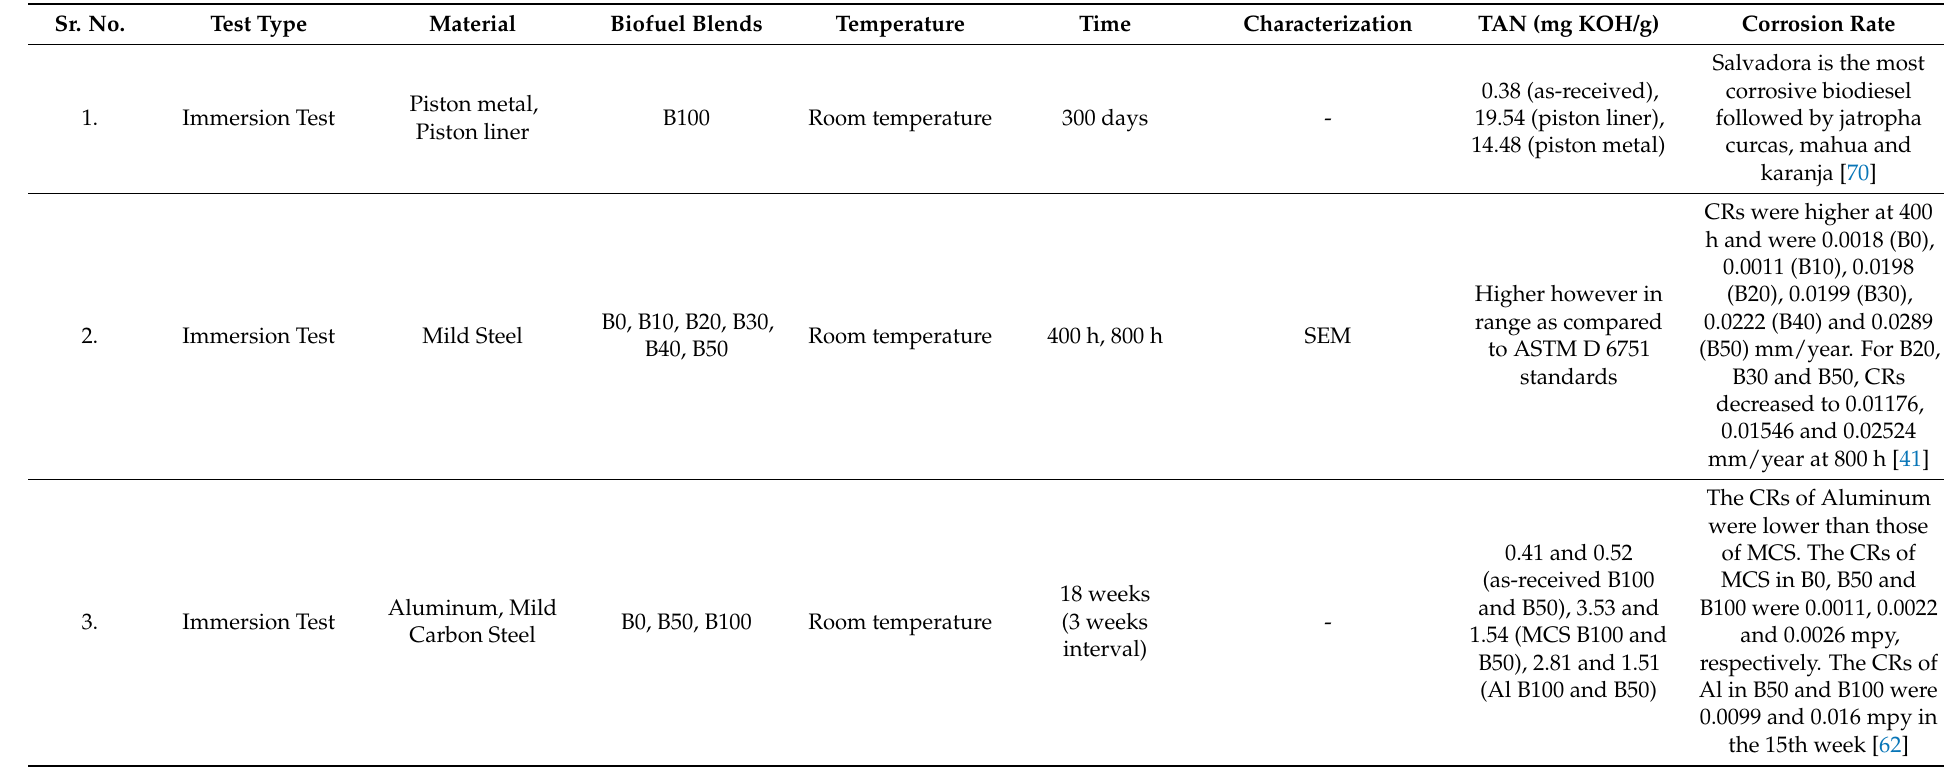
Table 2. Summary of corrosion studies using jatropha oil-based